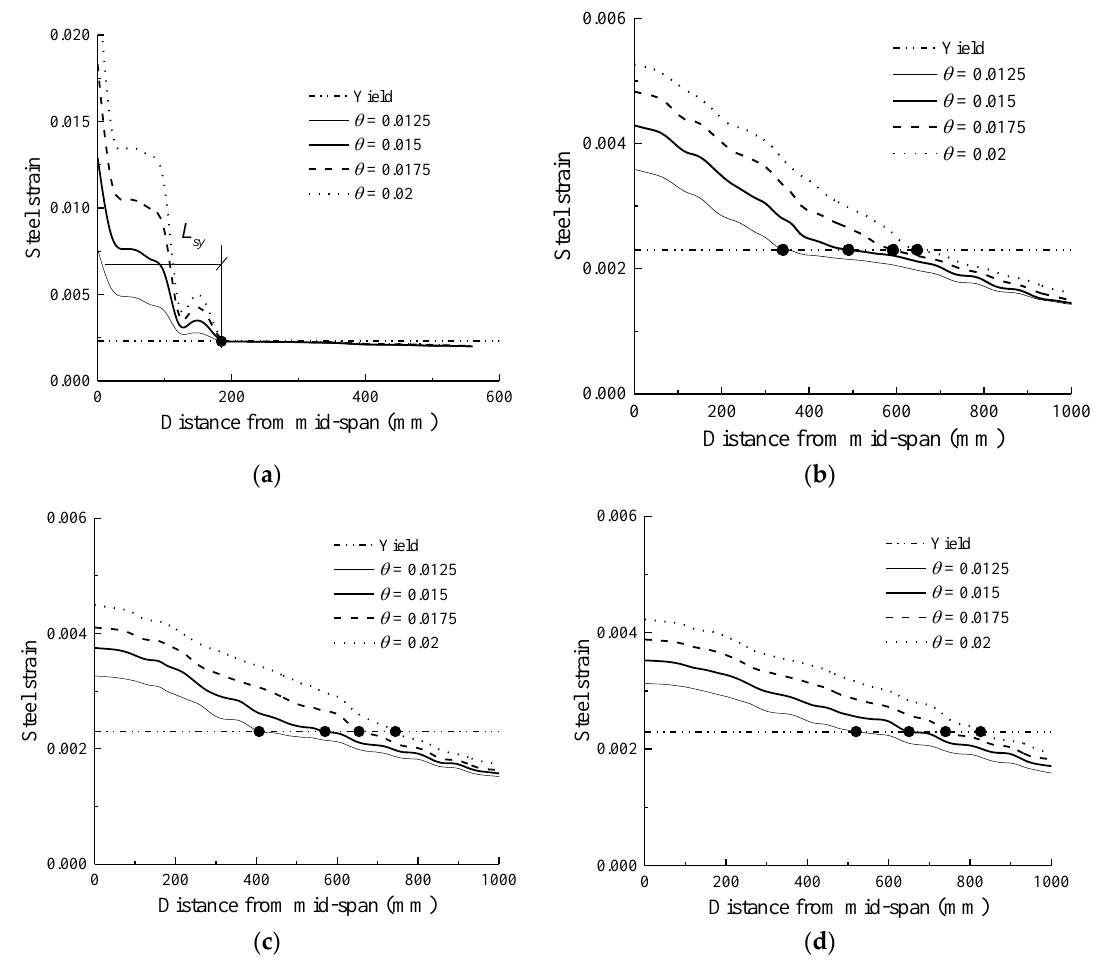
Figure 5. Longitudinal steel strain distribution: ( a ) ρ r = 0; ( b ) ρ r = 0.33; ( c ) ρ r = 1; ( d ) ρ r = 3.